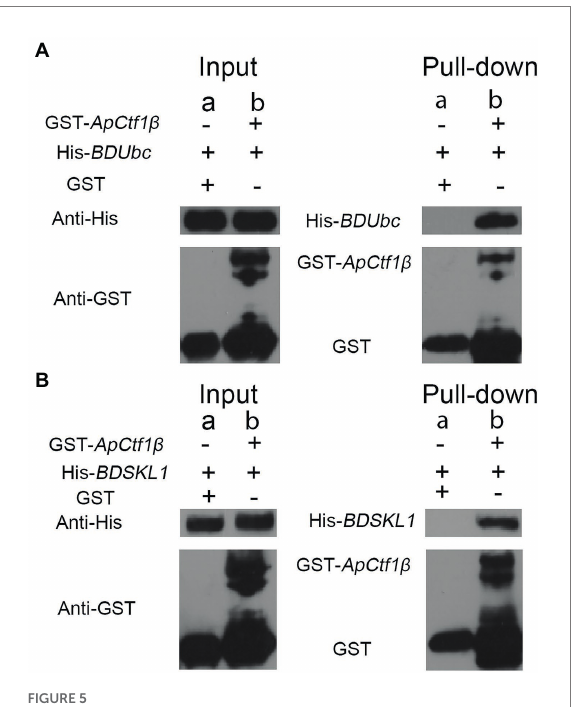
FIGURE 5 (A) GST pull-down assay of ApCtf1 β interacting with the BDUbc protein in vitro ; (B) GST pull-down assay of ApCtf1 β interacting with the BDSKL1 protein in vitro ; a: control group; b: experimental